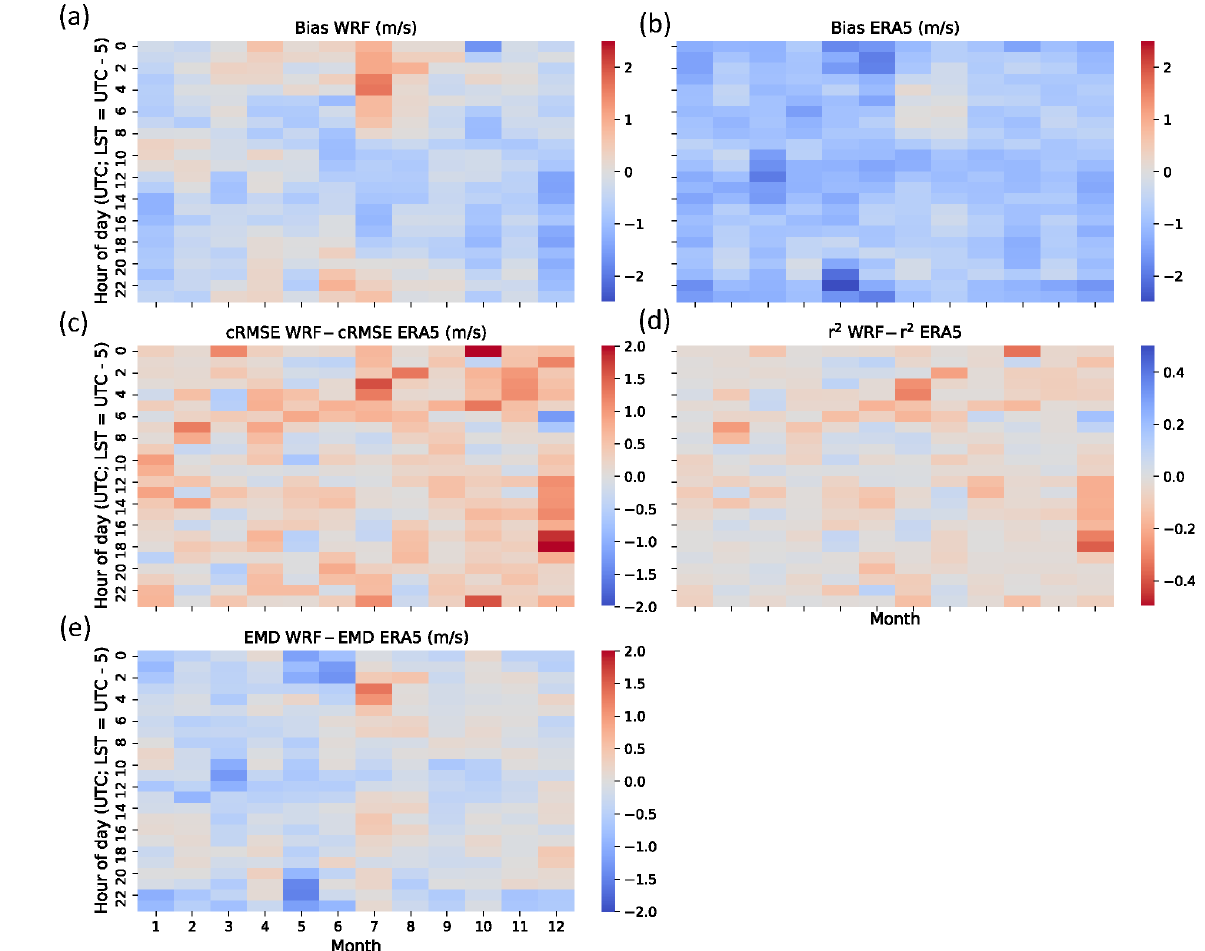
Figure 10. The 24 × 12 heat maps at the location of the E05 lidar showing the diurnal and seasonal variability in bias, cRMSE, r 2 , and EMD for the 100m wind speed. Results from the E06 lidar are included in the Supplement.